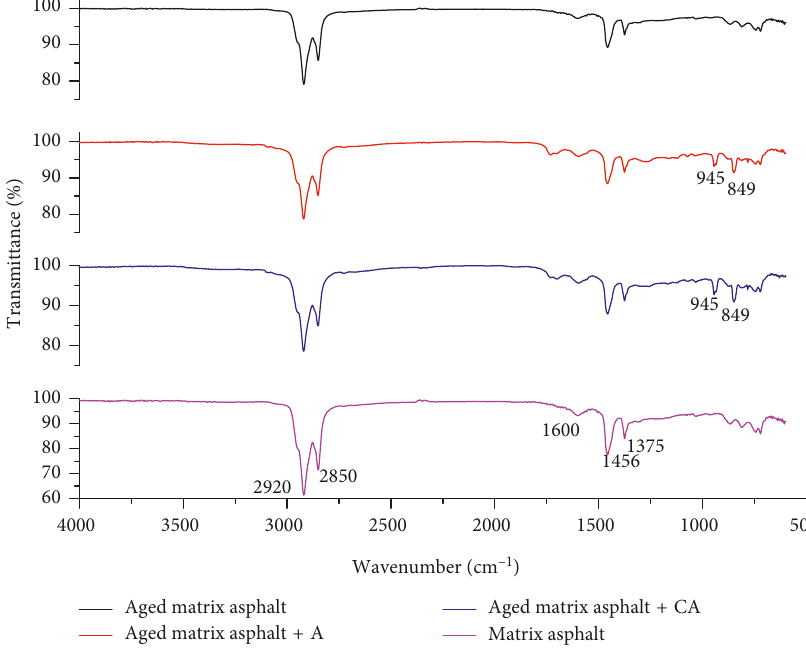
Figure 13: Comparison of FTIR spectra of several matrix asphalt